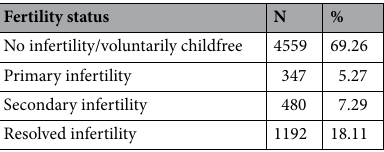
Table 2. The distribution of mutually exclusive ‘fertility status’ for 6580